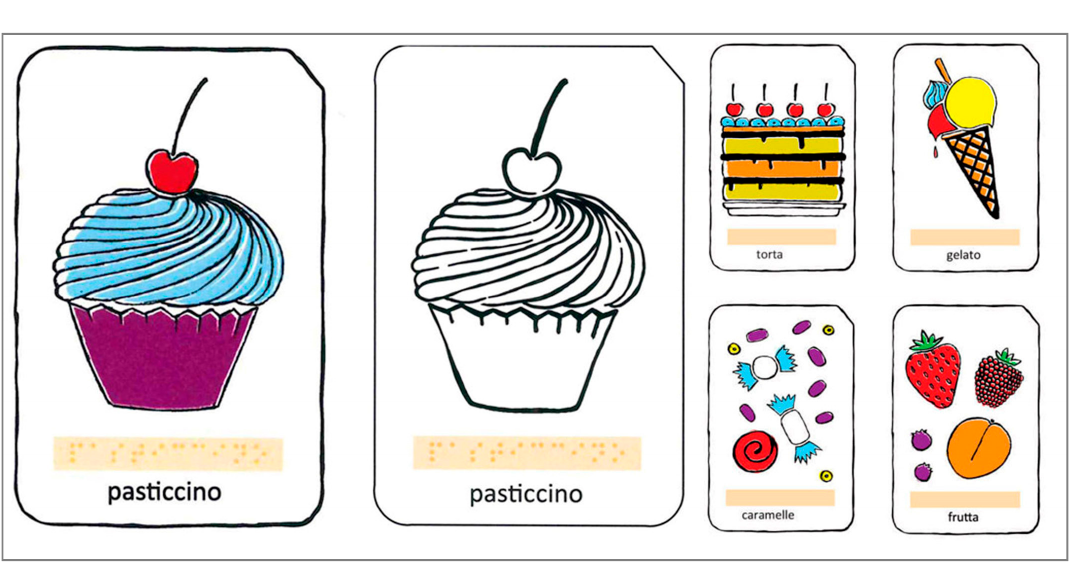
Figure 3. Some cards used for the memory game. The name of the subject is written in Braille, while the drawings have the contour lines in relief, in order to help the children to recognize the subjects. The cards have beveled edges: three of them are rounded, while the upper right corner is more linear. This is a tactile indicator that facilitates the correct reading direction of the card.